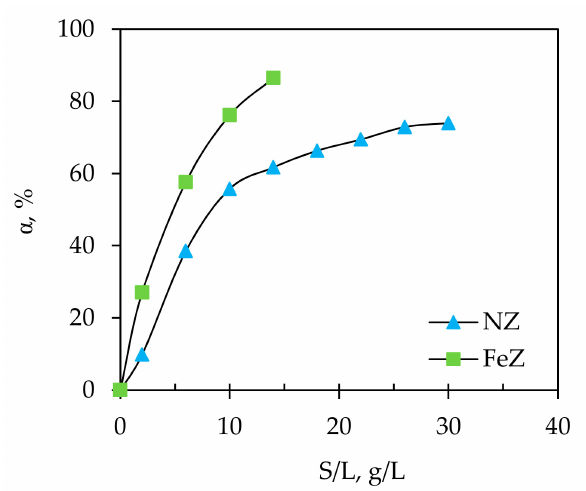
Figure 3. The e ff ect of solid / liquid ratio (S / L) ratio on removal e ffi ciency, α of Hg(II) onto NZ and FeZ.